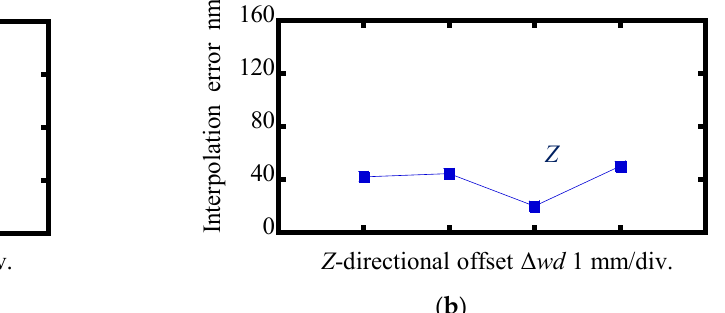
Z -directional offset Δ wd 1 mm/div.